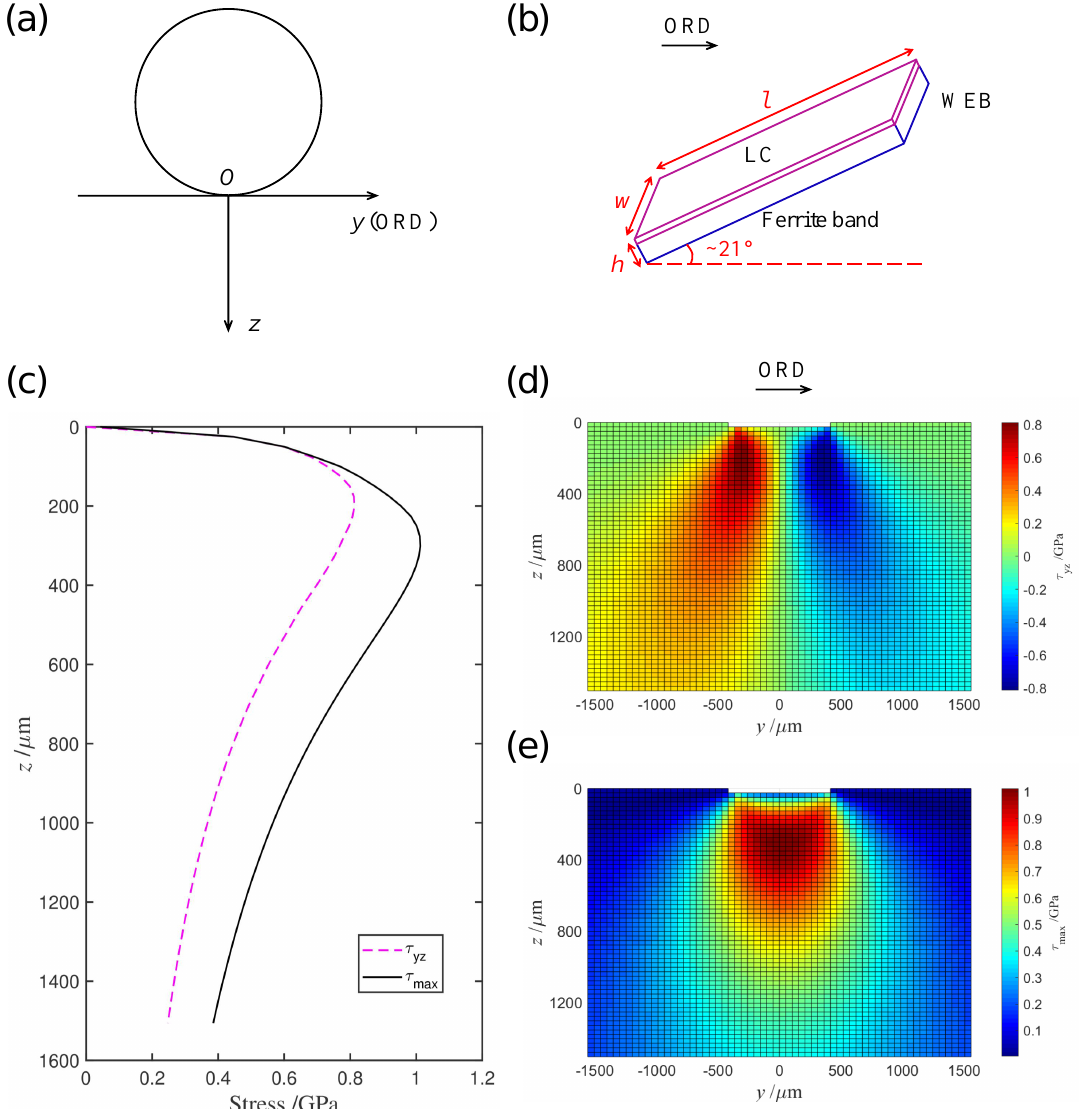
Figure 8. Stress analysis for WEB formation. ( a ) Schematic of rolling contact defining the coordinate system. ( b ) Schematic of a plate-like WEB. ( c ) Orthogonal and maximum shear stress components along the centre line of rolling contact. ( d ) Distribution of orthogonal shear stress in yz plane. ( e ) Distribution of maximum shear stress in yz